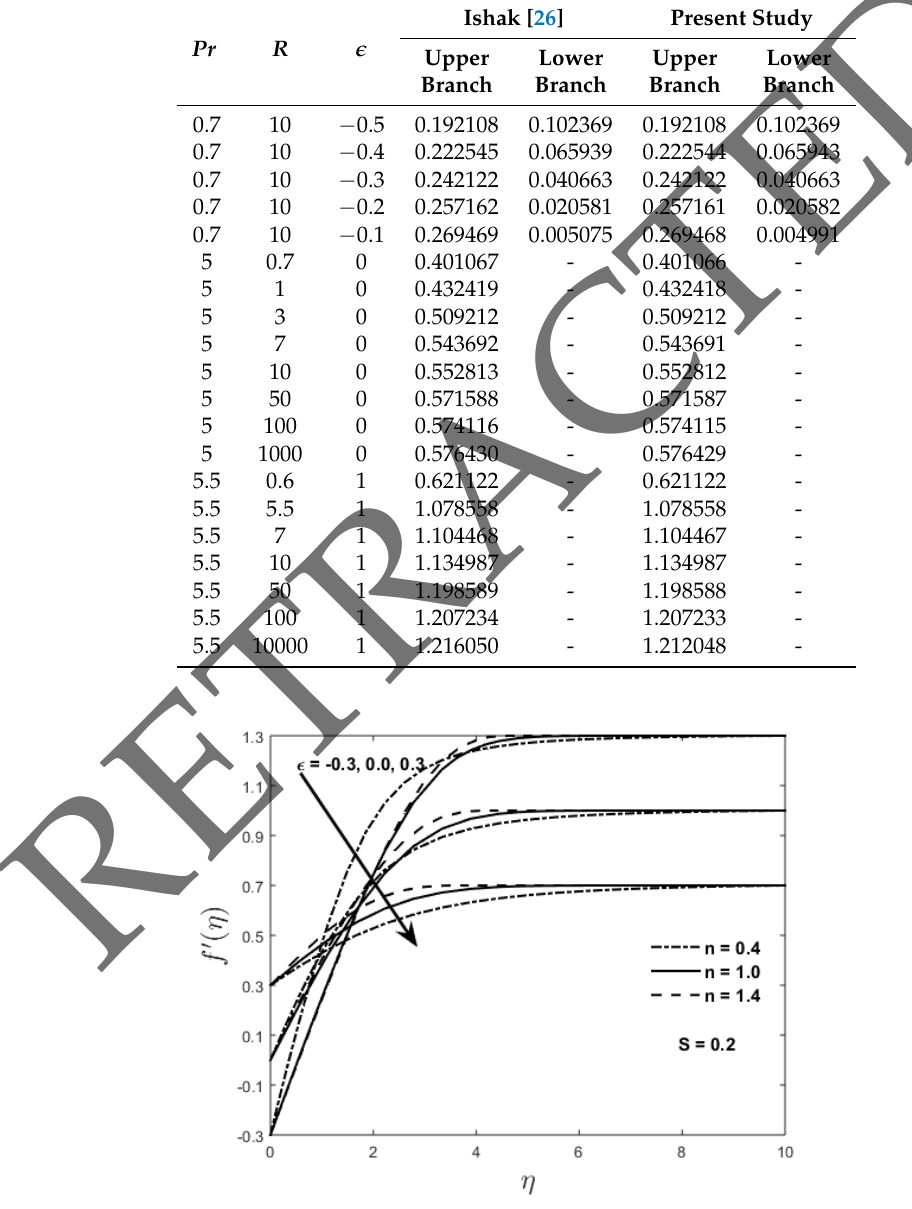
Figure 2. Velocity profiles for various values of (cid:101) and n